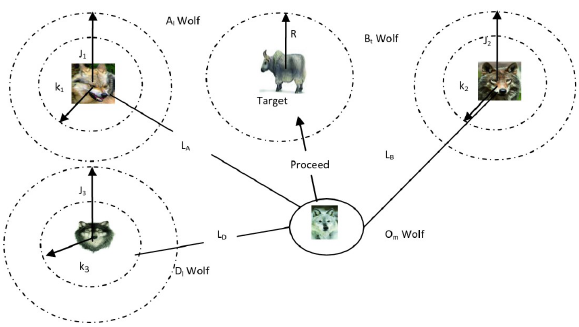
Fig. 6. How α , β , ω , and δ are defined in